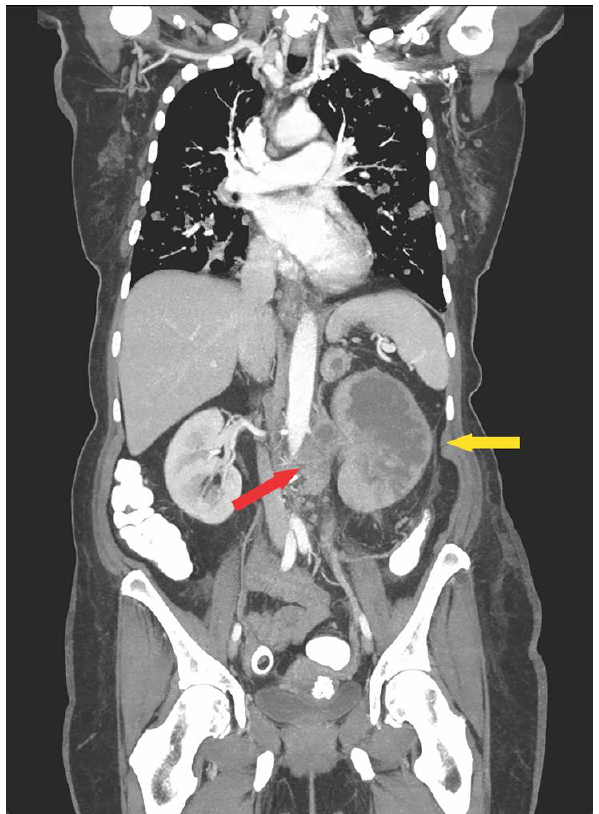
Figure 1. Computed tomography scan showing a renal mass infiltrating the left kidney (yellow arrow), also demonstrated a lymph node over the aorta (red arrow).